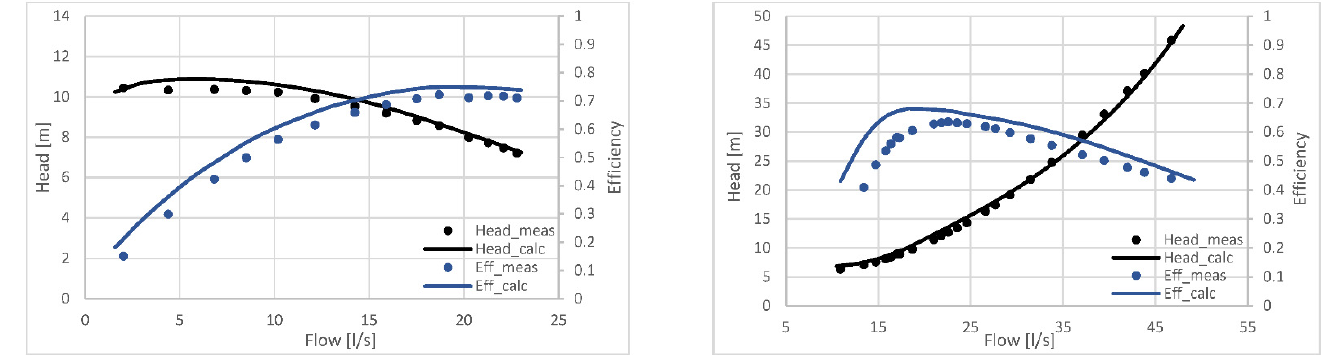
Figure 11. ( A ) Head and efficiency for the PAT 80-160 (ns = 40.24) in pump operation. ( B ) Head and efficiency for the PAT 80-160 (nst = 32.94) in turbine operation.